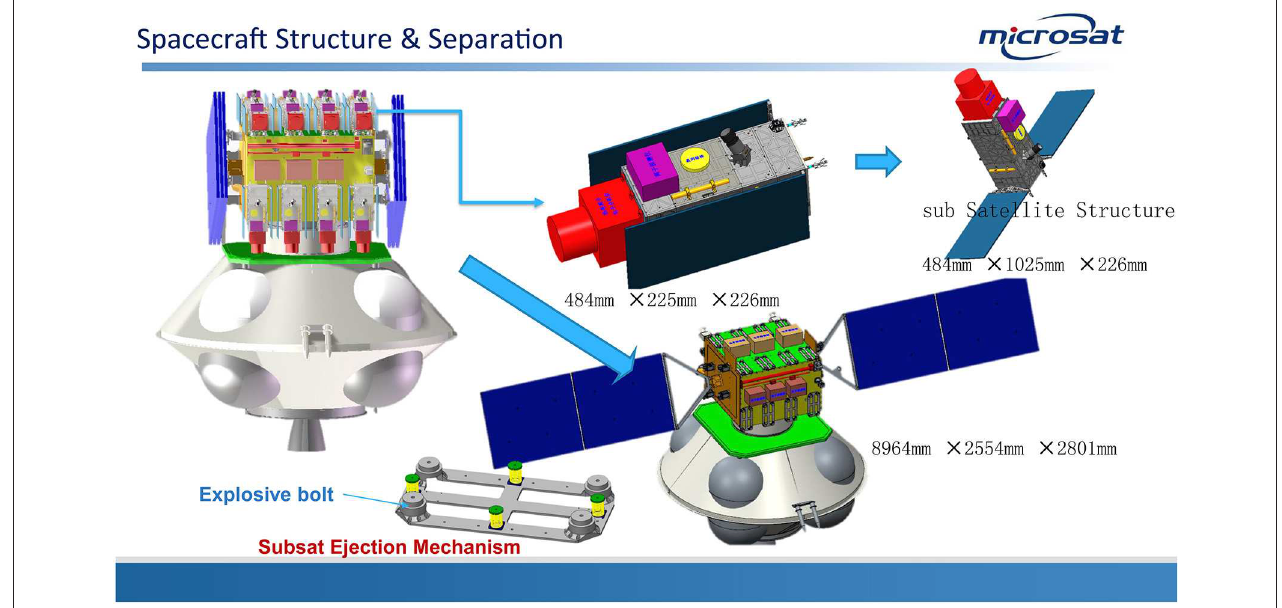
FIGURE 8 | The configuration of the main spacecraft and the CubeSats of the AME mission.